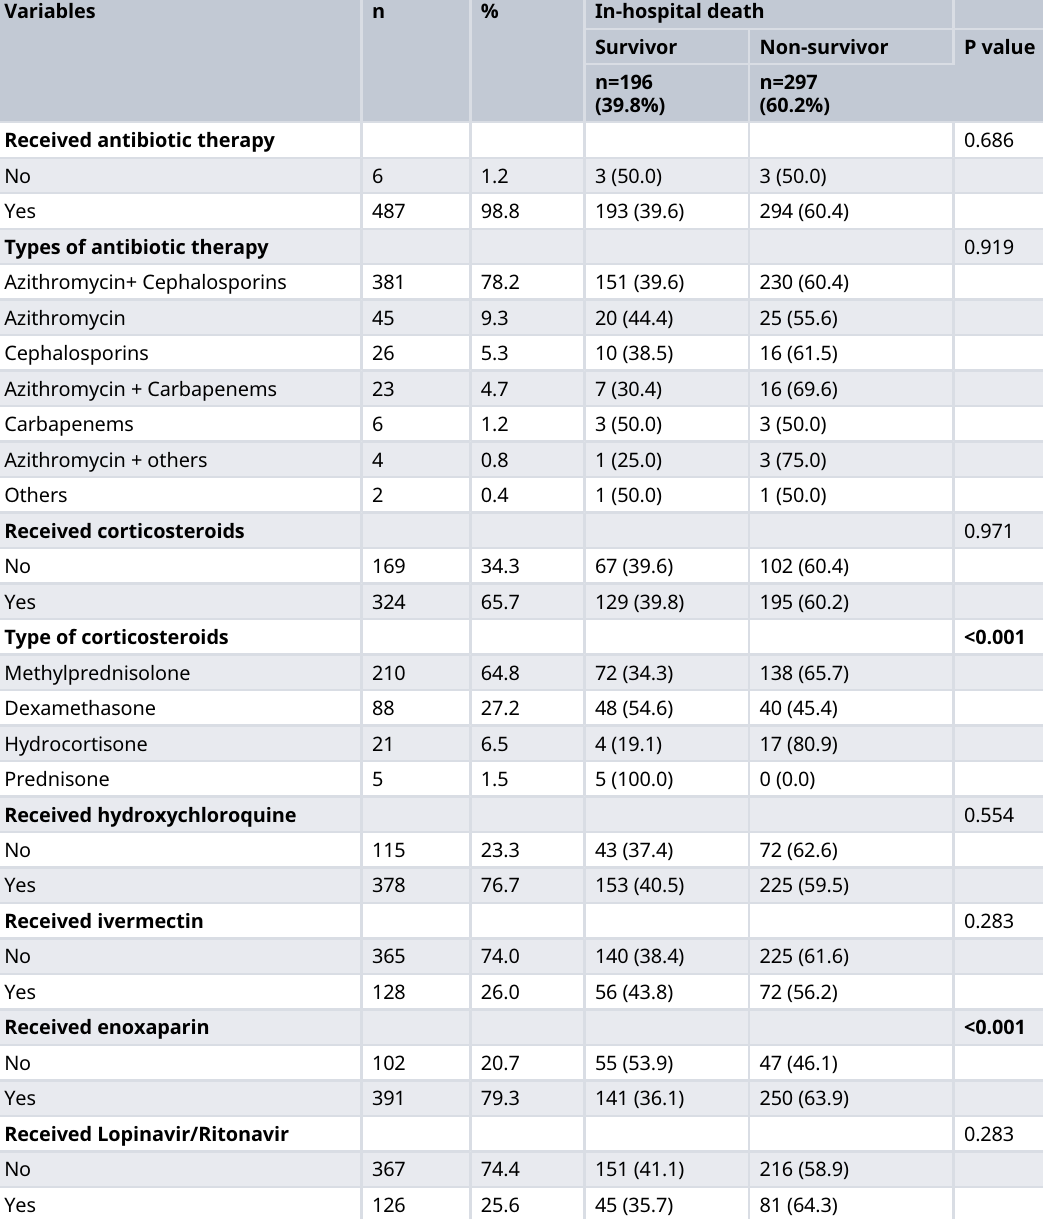
Table 2. Descriptive and bivariate analysis of the treatment received according to in-hospital death in the study sample.